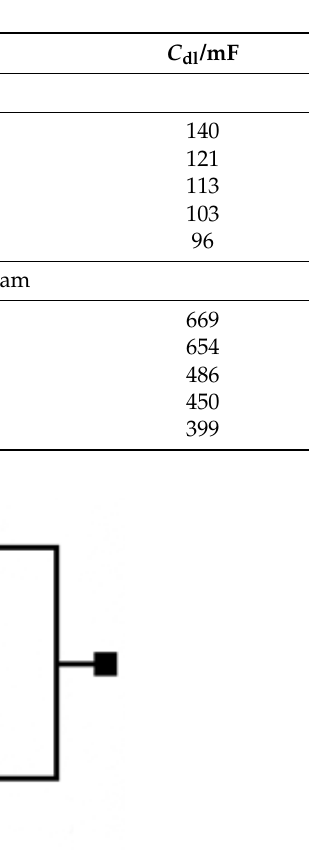
Table 3. a.c. impedance parameters (total, average values of charge-transfer resistance, R ct and double-layer capacitance, C dl parameters), derived for a single electrolyser cell (anode: Ni foam; cathode: unmodified and Pd-modified Ni foam) recorded in 8 M KOH solution, at the temperature of 45 ◦ C.